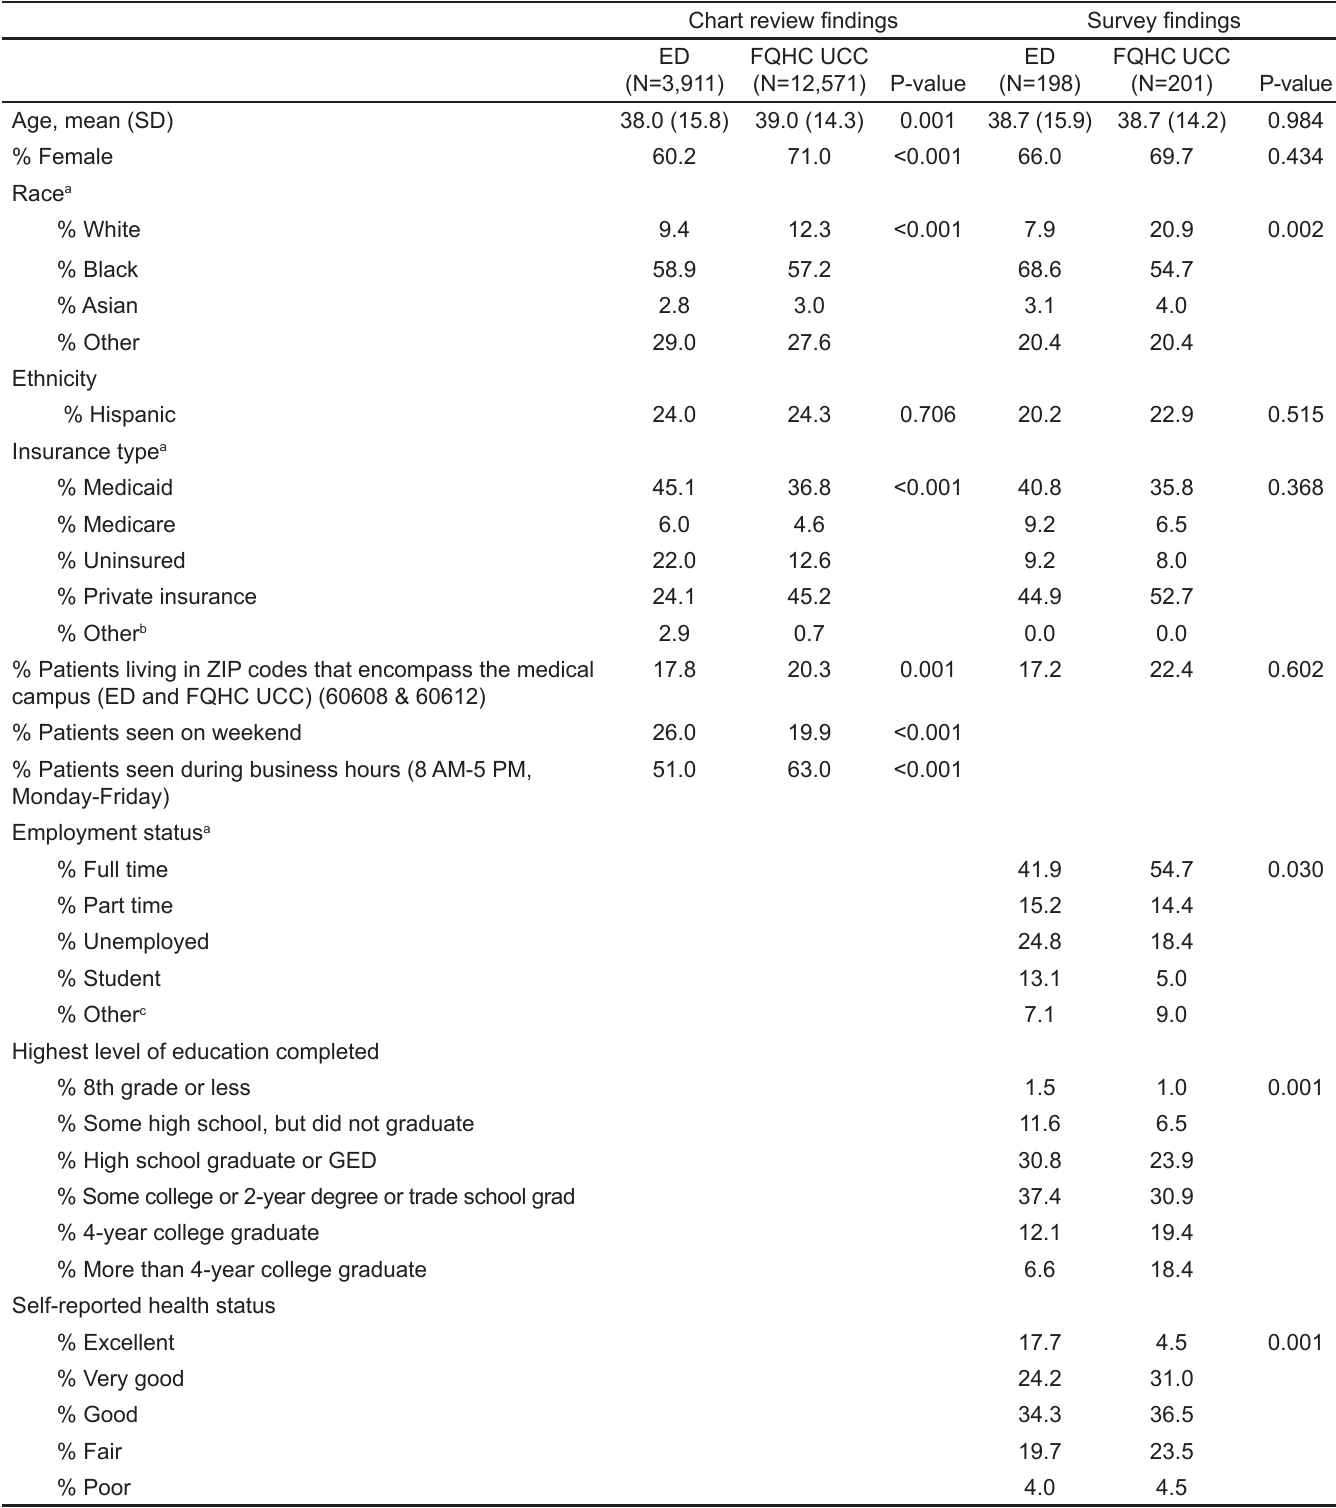
Table 1. Emergency department patients with Emergency Severity Index (ESI) 4 or 5 survey respondents, and federally qualified health center urgent care center patient survey respondents: demographics and the current day’s